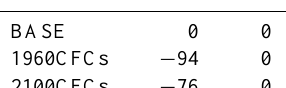
Table 1. Percentage (%) differences in surface CFC and N 2 O con- centrations between the various sensitivity experiments and the BASE simulation.